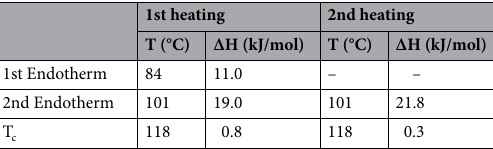
Table 3. Enthalpies of phase transitions detected in the case of TAPAm.